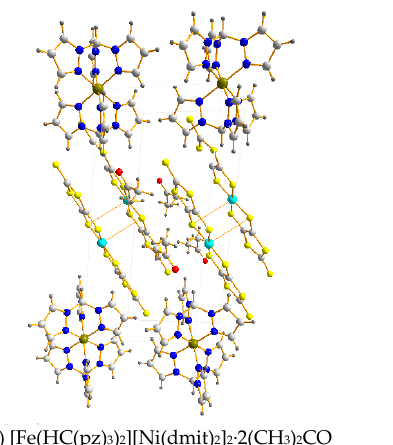
Figure 8. μ eff ( Т ) curve of [Fe(HC(pz) 3 ) 2 ][Fe(HC(pz) 3 )(NCS) 3 ]NCS. Mössbauer spectra of complexes are poorly resolved lines with parameters (chemical shift δ and quadruple splitting ε ) shown in Table 5 and Figure 9. The δ values are in the region of shifts characteristic of LS Fe(II) complexes, lower than those in previously studied Fe(II) complexes with 1,2,4-triazoles (0.416—0.427) [69], which gives evidence that chemical Fe—N bonds in new complexes are more covalent. This fact, in turn, confirms the conclusion drawn in [20] that tris(pyrazol-1-yl)methane is a stronger field ligand in comparison with 1,2,4-triazole and 4-amino-1,2,4-triazole ( NH 2 trz ). This makes it possible to understand the main reason why SCO temperatures are higher in iron(II) complexes with HC(pz) 3 than those in the complexes with 1,2,4-triazoles [70]. At the same time, there is no direct proportionality between Т с and Δ LS . Small quadruple splittings indicate a weak distortion of the octahedral environment of iron atoms in it (as in Fe(II) complexes with 1,2,4-triazoles). Table 5. Basic Mössbauer parameters of the iron(II) complexes. Complex